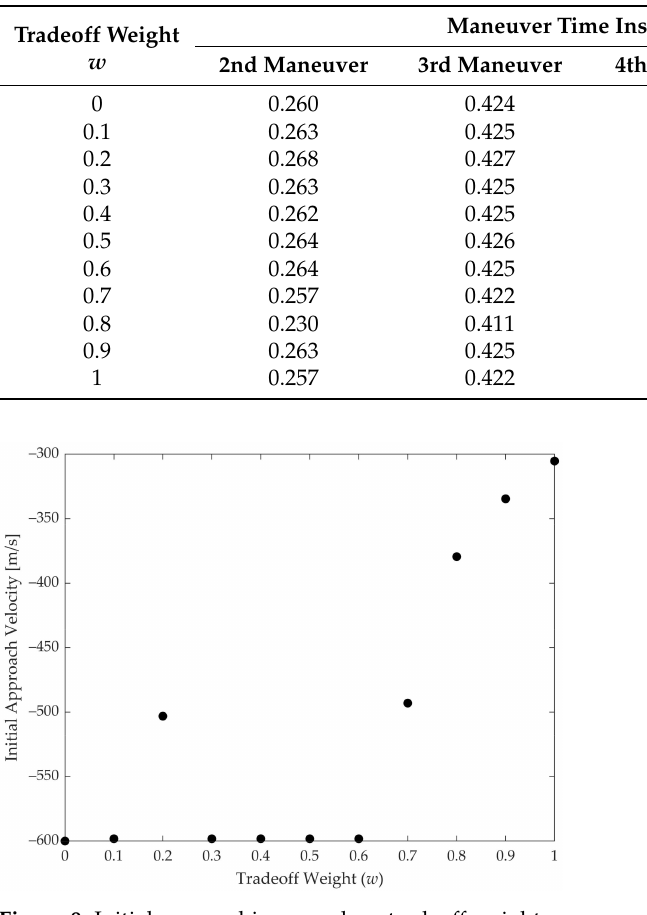
Figure 9. Initial approaching speed vs. tradeoff weight.